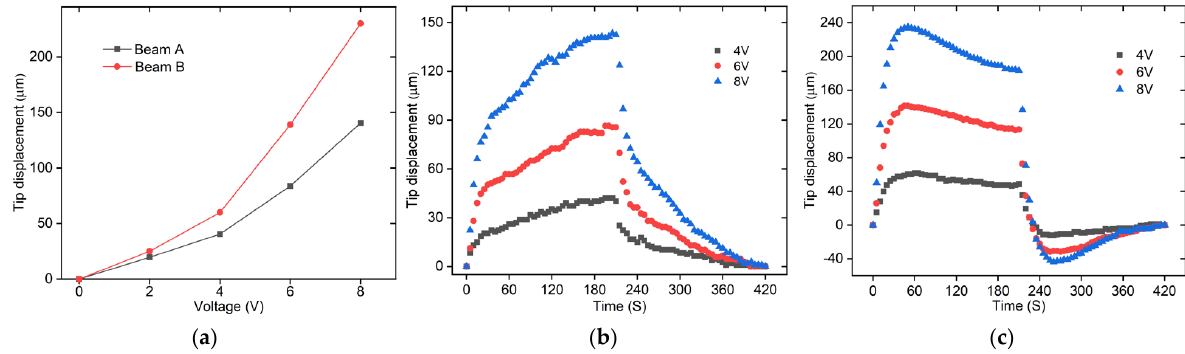
Figure 13. The static and dynamic testing of the Z-shaped actuator. ( a ) The static displacements vs. voltages of the Z-shaped actuator; ( b ) The dynamic displacements of the beam A; ( c ) The dynamic displacements of the beam B.